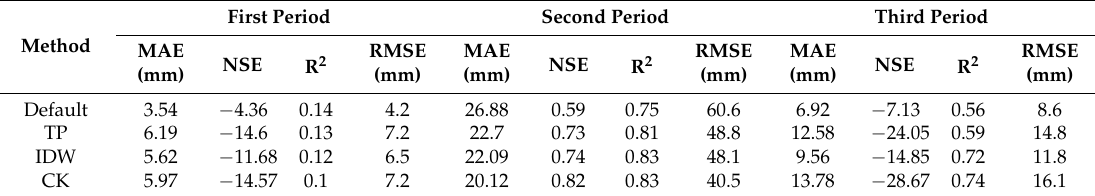
Table 4. Performance assessment of runoff simulation with different interpolation schemes during three periods.